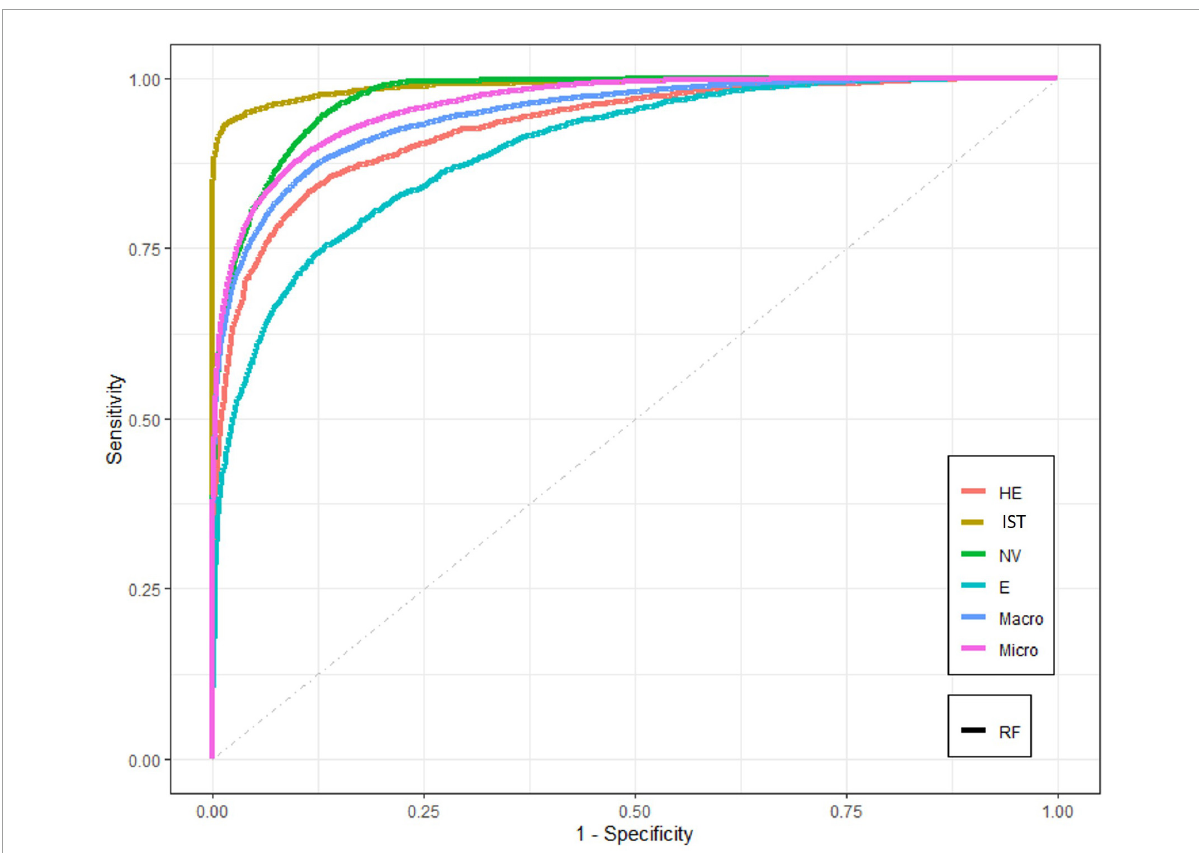
FIGURE4 The receiver operating characteristic (ROC) curves for RF model for dataset A. Abbreviations: RF, random forest; HE, hypoechogenicity; NV, neovascularity; IST, intrasubstance tear; E, enthesopathy; Macro, macro-AUC; Micro, micro-AUC.